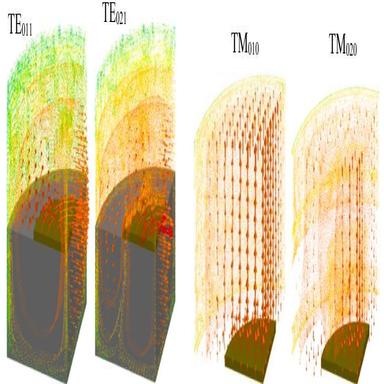
E-field distributions in resonator R12 (modes TE011 and TE021) and resonator R22 (modes TM010 and TM020), in which sample diameter is smaller than the resonator diameter (18.1 mm).